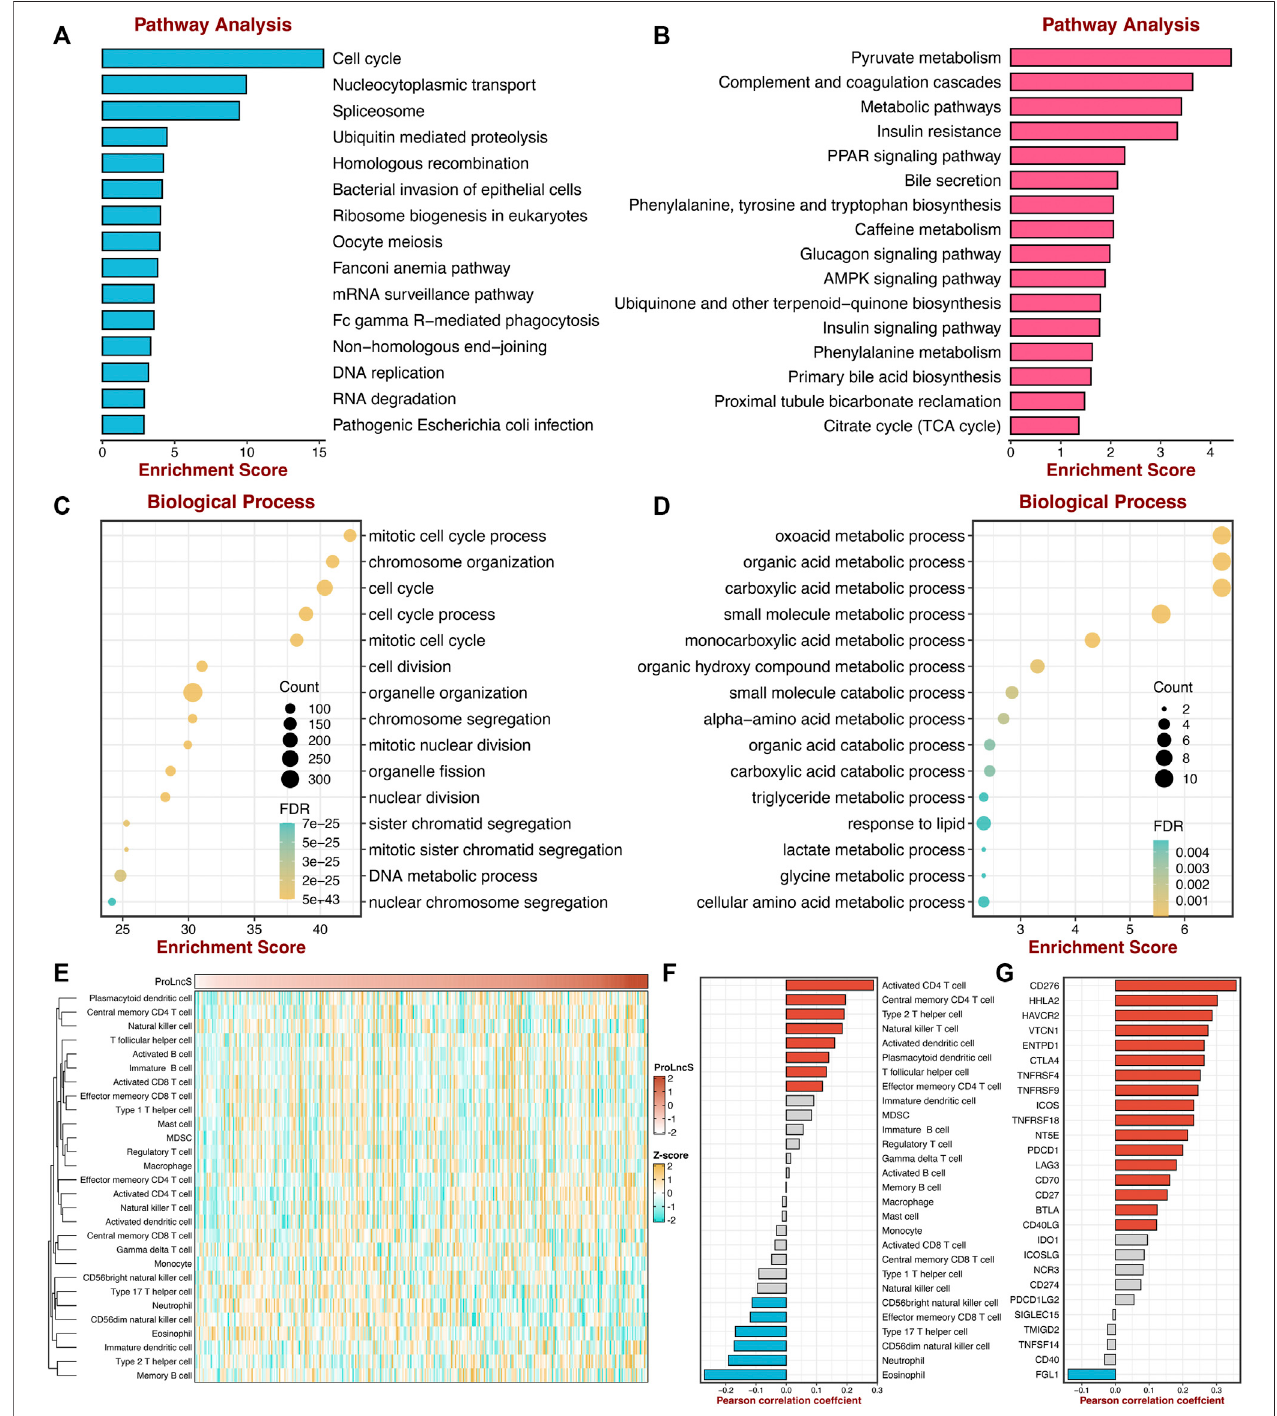
FIGURE 10 | Exploring the potential mechanisms of ProLncS. (A,B) The KEGG pathway enrichment analysis of genes signi fi cantly correlated with ProLncS. The top 15 positive (A) and negative (B) pathways are associated with ProLncS. (C,D) GO enrichment analysis of the top 15 positive (C) and negative (D) biological processes. (E) Distribution of 28 immune cells with ProLncS. (F) Correlations between ProLncS with 28 immune cells. (G) Correlations between ProLncS with 27 immune checkpoint molecules. Red and blue bars mean p < 0.05, and grey bar means p > 0.05.